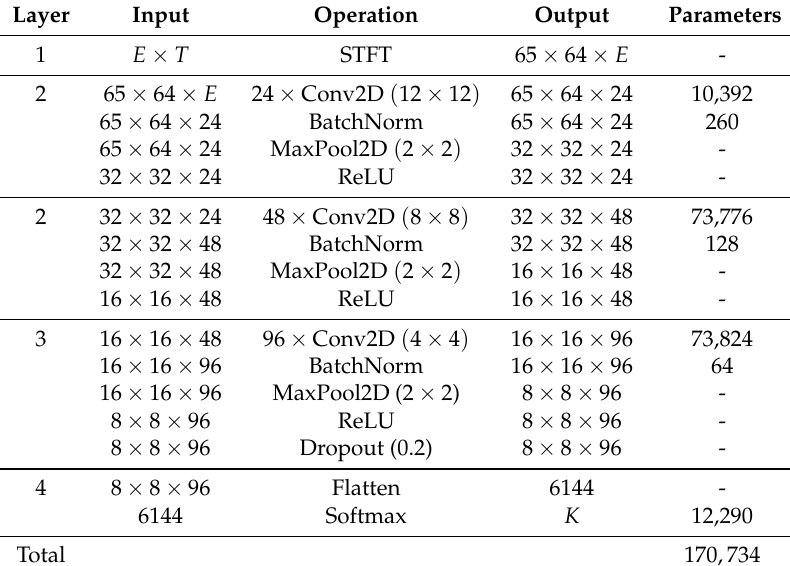
Table A1. Pragmatic CNN (pCNN) architecture. E is the number of channels, T is the number of timesteps and K is the number of classes. Input and Output sizes are shown for cropped training with E = 3 (electrodes C3, C4, and Cz) and T = 1024 for window size of 4 seconds; binary classification with two classes for K =